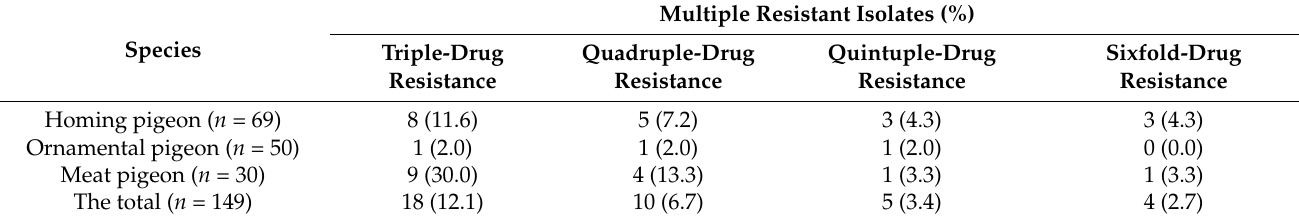
Table 2. The multi-drug resistance of E. coli from different pigeon species to 8 classes of antibiotics.